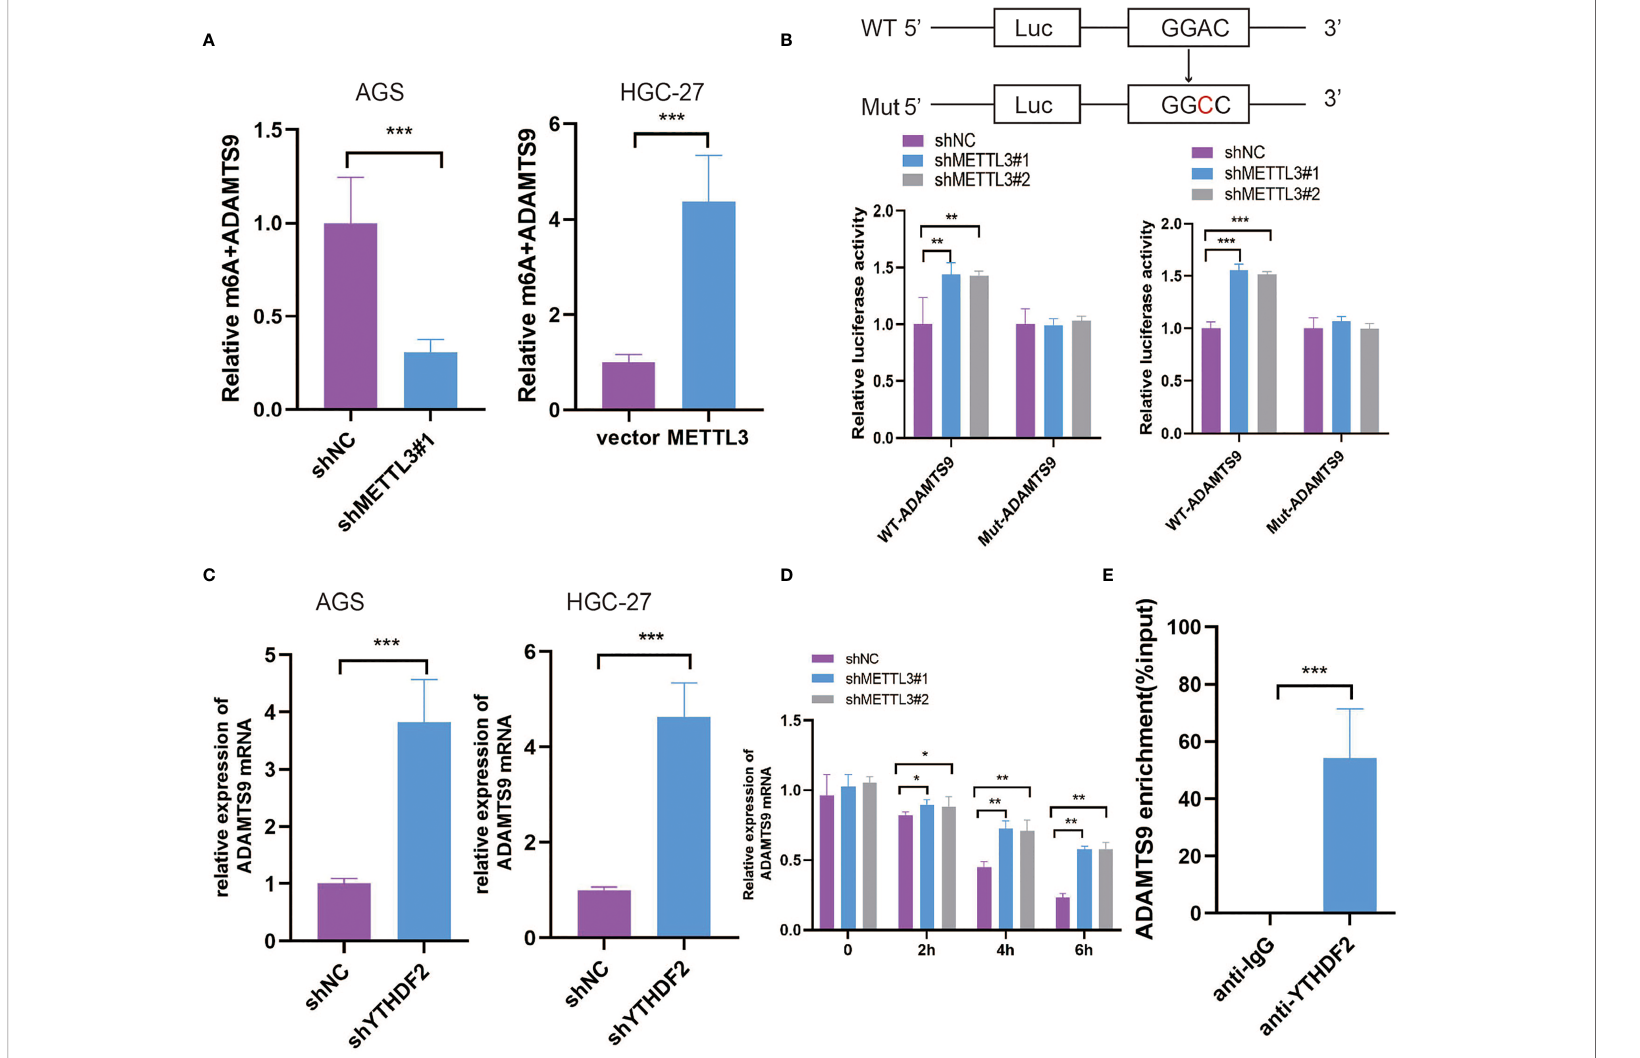
FIGURE 5 | METTL3 decreased ADAMTS9 mRNA stability through m6A-YTHDF2 dependent pathway. (A) The regulation of METTL3 on ADAMTS9 m6A modi fi cation was evaluated in different GC cells. (B) The post-transcription level of ADAMTS9 was detected in METTL3-knockdown GC cells by using fi re fl y luciferase reporter assay. (C) The level of ADAMTS9 mRNA was detected in YTHDF2 knockdown GC cells by qRT-PCR. (D) ADAMTS9 mRNA was analyzed at indicated times in METTL3 knockdown and control AGS cells with Act-D treatment. (E) RIP-qPCR assay was used to detect the enrichment of YTHDF2 binding to ADAMTS9 m6A modi fi cation sites. *P < 0.05, **P < 0.01, ***P <